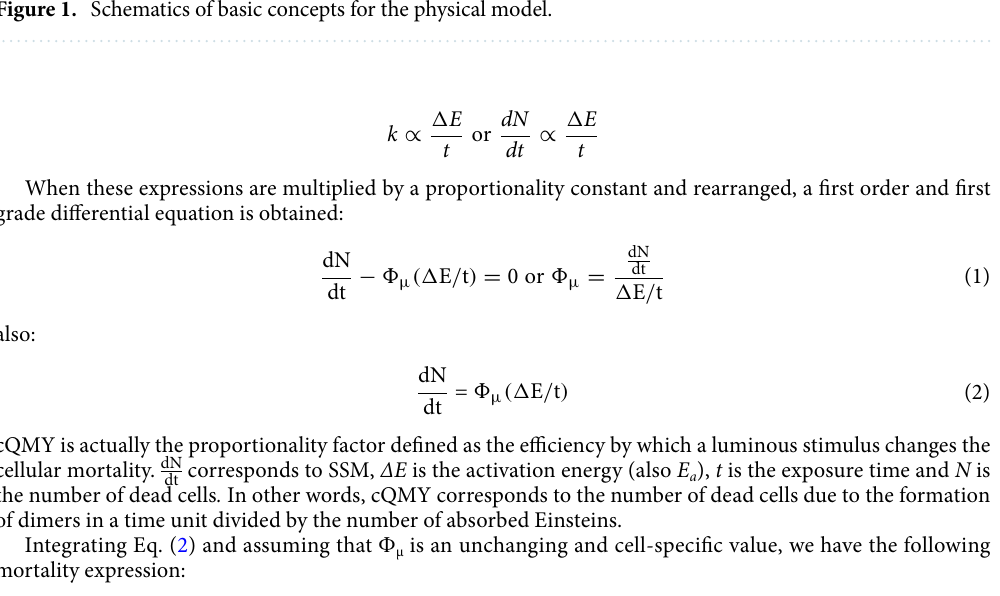
Figure 1. Schematics of basic concepts for the physical